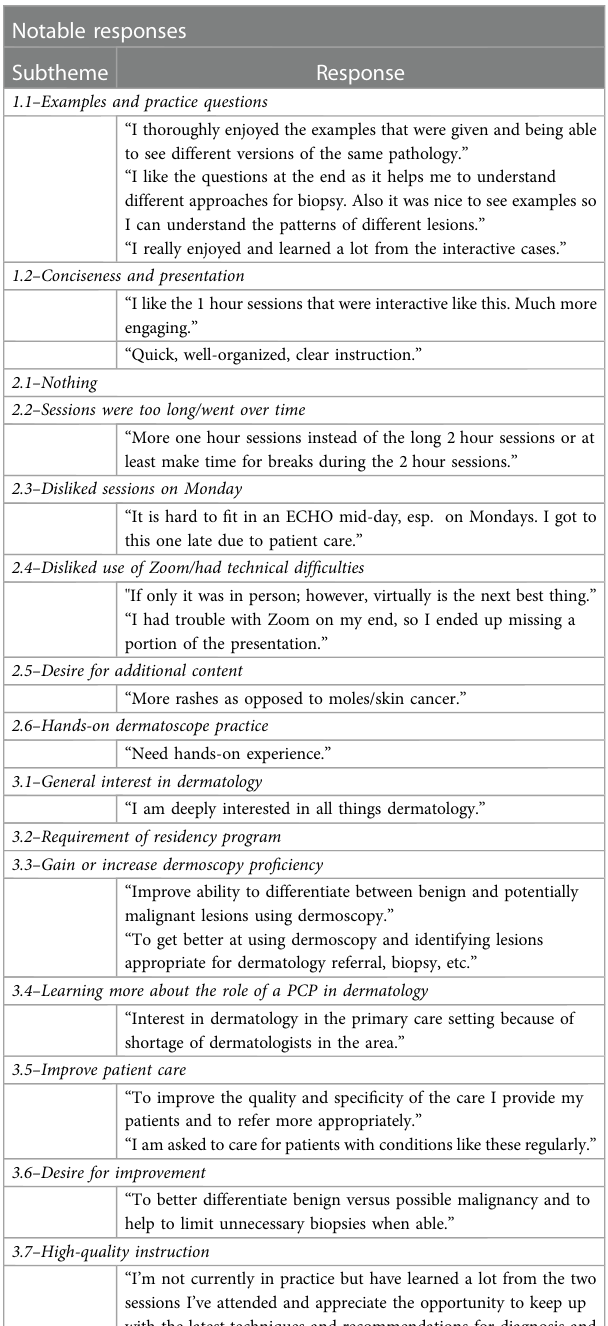
TABLE 2 Subtheme exemplar